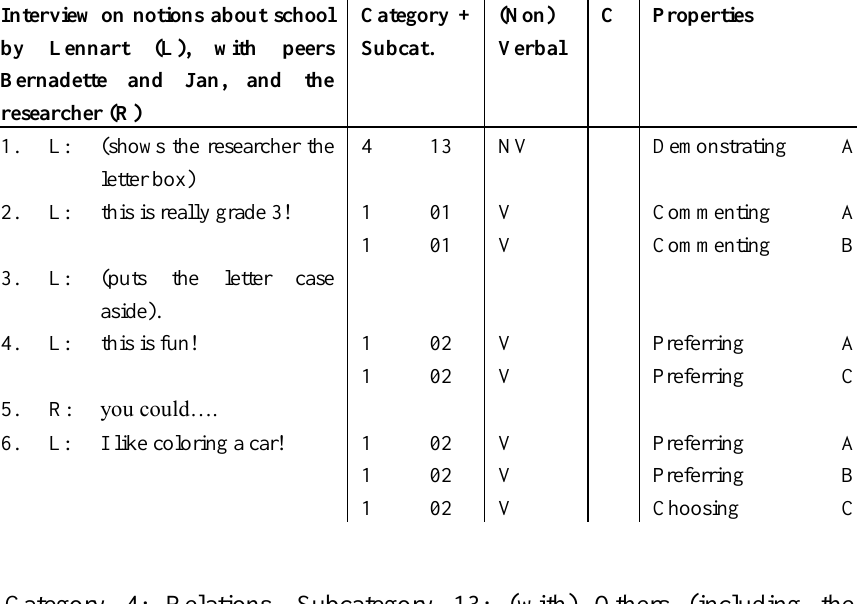
Category 4: Relations. Subcategory 13: (with) Others (including the researcher) Category 1: School activities. Subcategory 01: Knowledge &